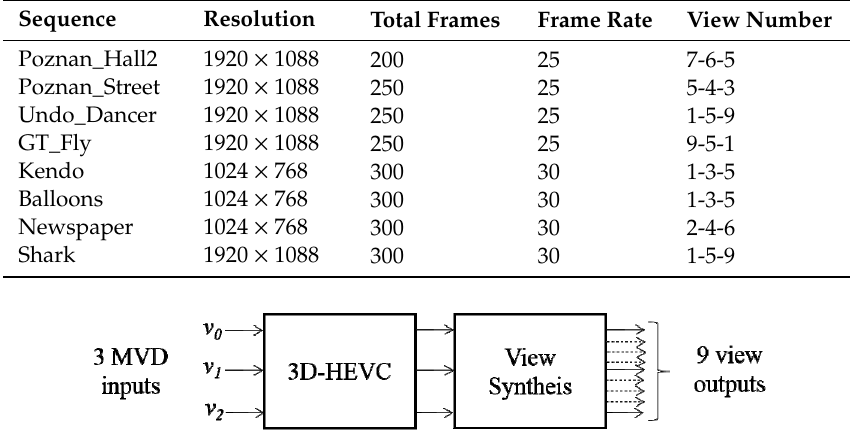
Figure 8. Three-view configuration including the left, center, right views in the 3D video coding.